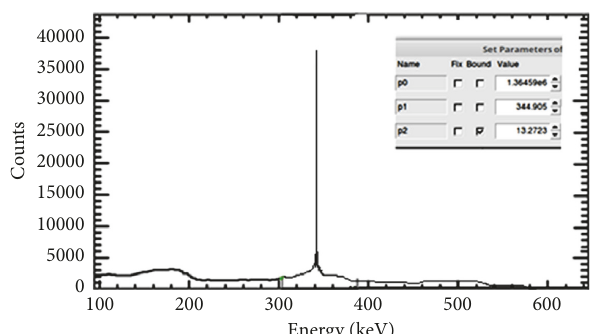
Figure 6: The simulated spectrum at 344keV using Gaussian distribution in monoenergetic